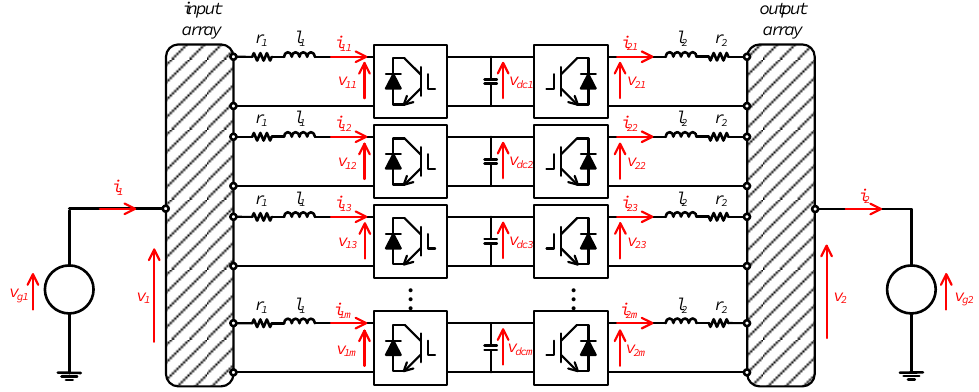
Figure 10. A generalized representation of a m -modules CHB-B2B